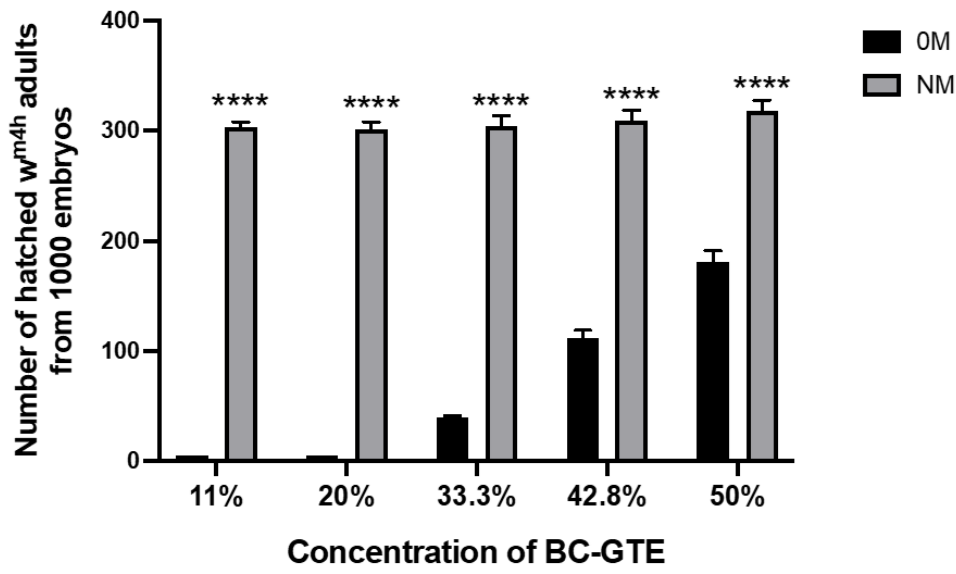
Figure 2. Effects of exposure to different concentrations of BC-GTE on the survival of Drosophila melanogaster. Abbreviations: 0M-zero media, NM-normal media; (****) p < 0.0001 zero media vs. normal media group. The values are mean ± SEM, n = 1000.